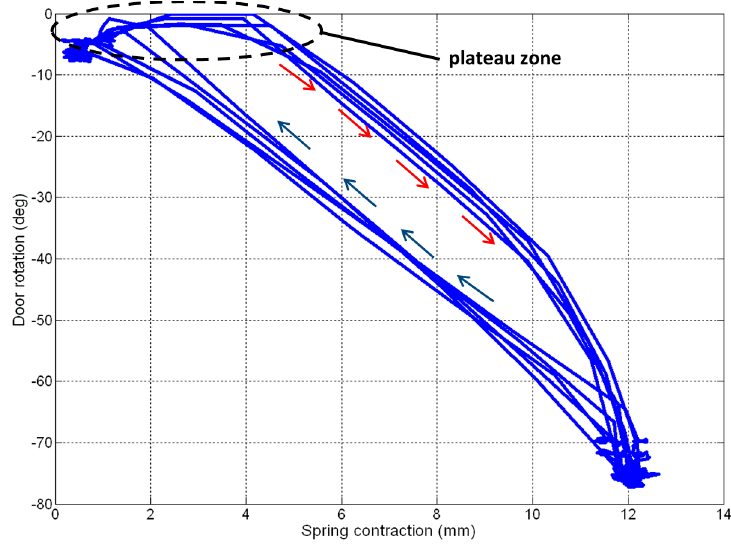
Figure 18. Five activation cycles: door opening and closing (red and blue arrows). Figure 2. Five activation cycles: door opening and closing (red and blue arrows).